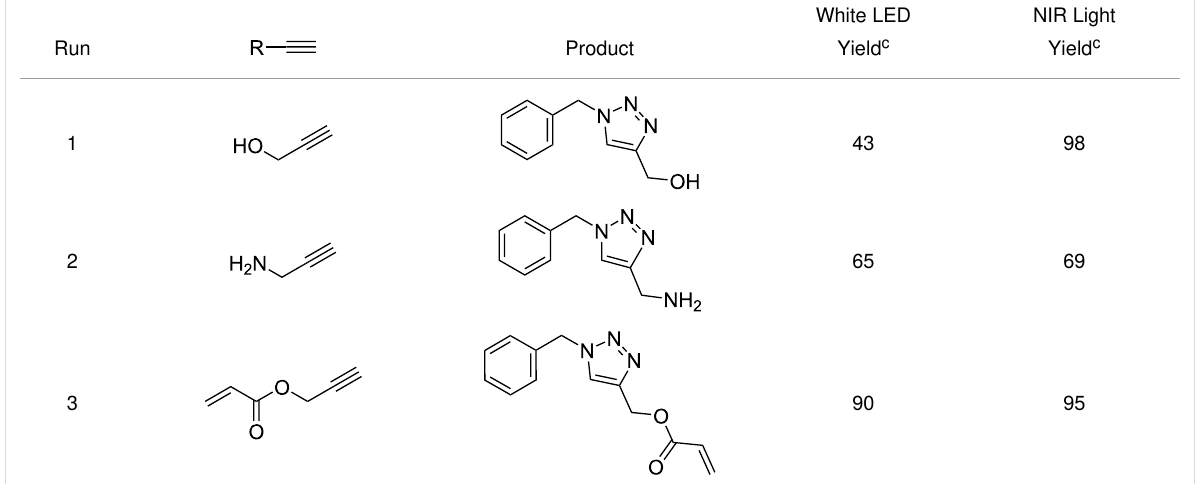
Table 1: Photoinduced CuAAC between benzyl azide and various alkynes a using exfoliated BPNs b in DMSO- d 6 = 1